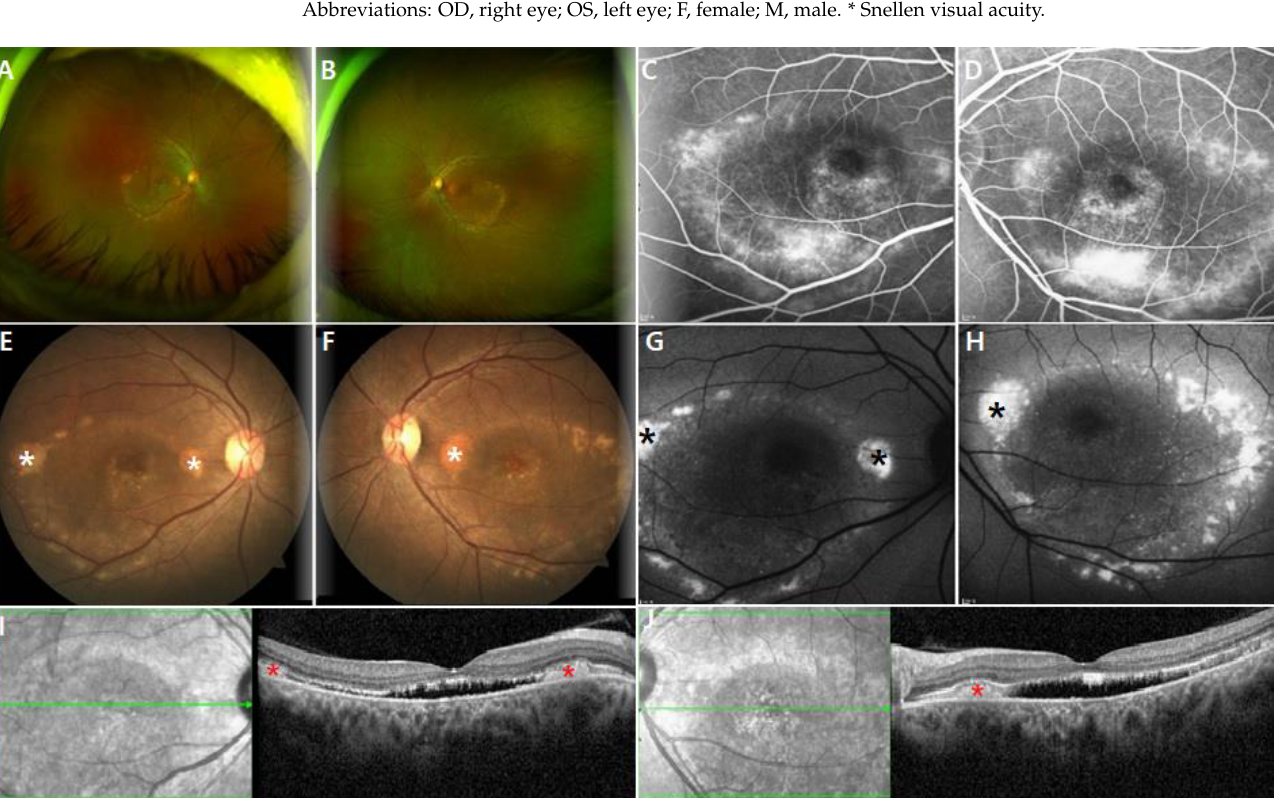
the right eye and 0.8 for the left eye, while the patient complained of subjective vision decrease only in the right eye despite the maculopathy in both eyes. ( A , B ) Widefield color images show bilateral